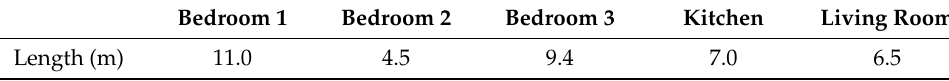
Figure 4. Typical floor plan for multi-story apartment in Korea. Table 4. Designed duct length of each room from air handling Table 3. Input variable for energy simulation based on Korean building code of multi-stories apart- ment.